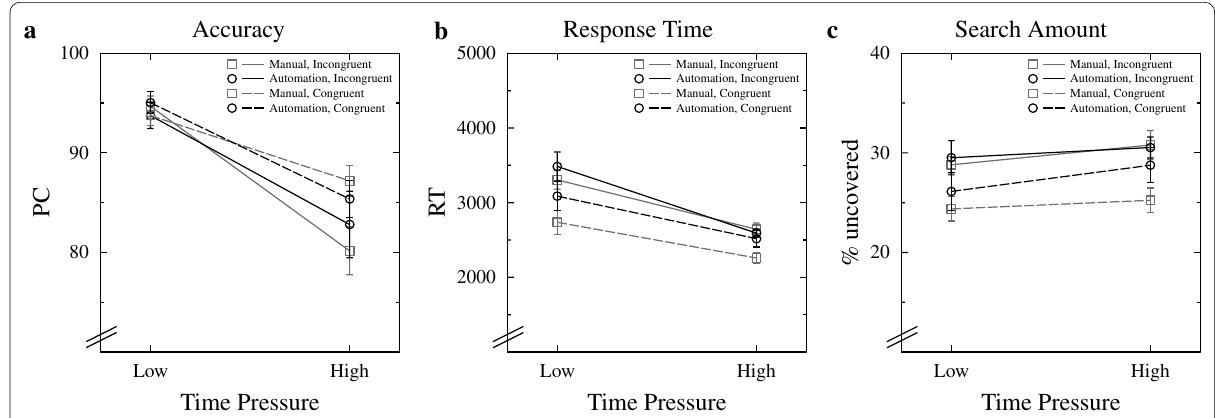
Fig. 3 Data for percent correct ( a ), response times ( b ), and search amount ( c ), separately for each time-pressure condition, as a function of automation condition and target location congruency. Note that this analysis was limited to the target-present trials. Error bars represent standard errors of the mean. PC: percent correct, RT: response